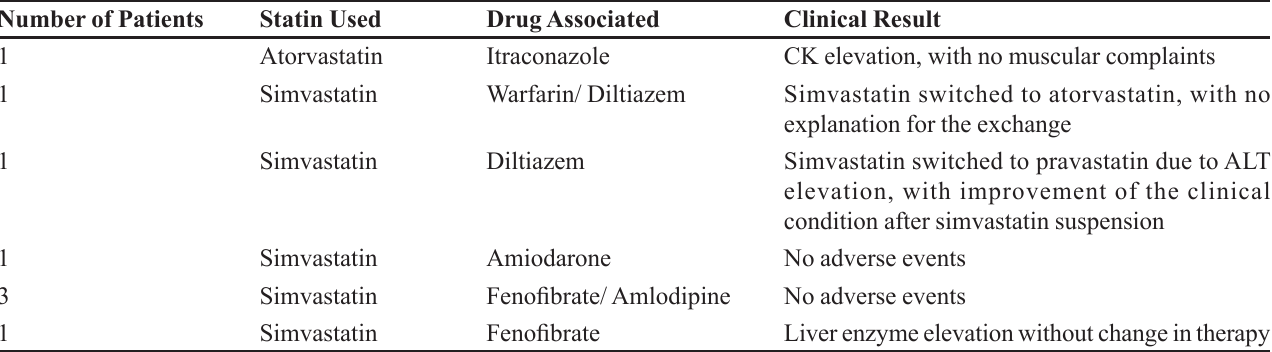
TABLE II - Major interactions between statins and therapy drugs used by dyslipidemic patients Number of